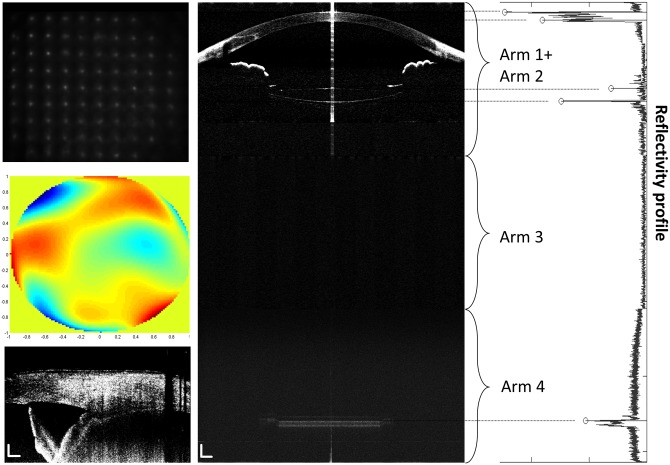
Typical images of a pseudophakic eye obtained with the combination system.Shack-Hartmann wavefront sensor spot patterns with a 0D accommodation stimulus (upper left). Higher order aberration image with a 0D accommodation stimulus (middle left). CM-OCT ciliary muscle image with a 0D accommodation stimulus (lower left). Bars = 500 μm (C) CMOS-OCT whole eye image with a 0D accommodation stimulus (right). Bars = 1000 μm (D).